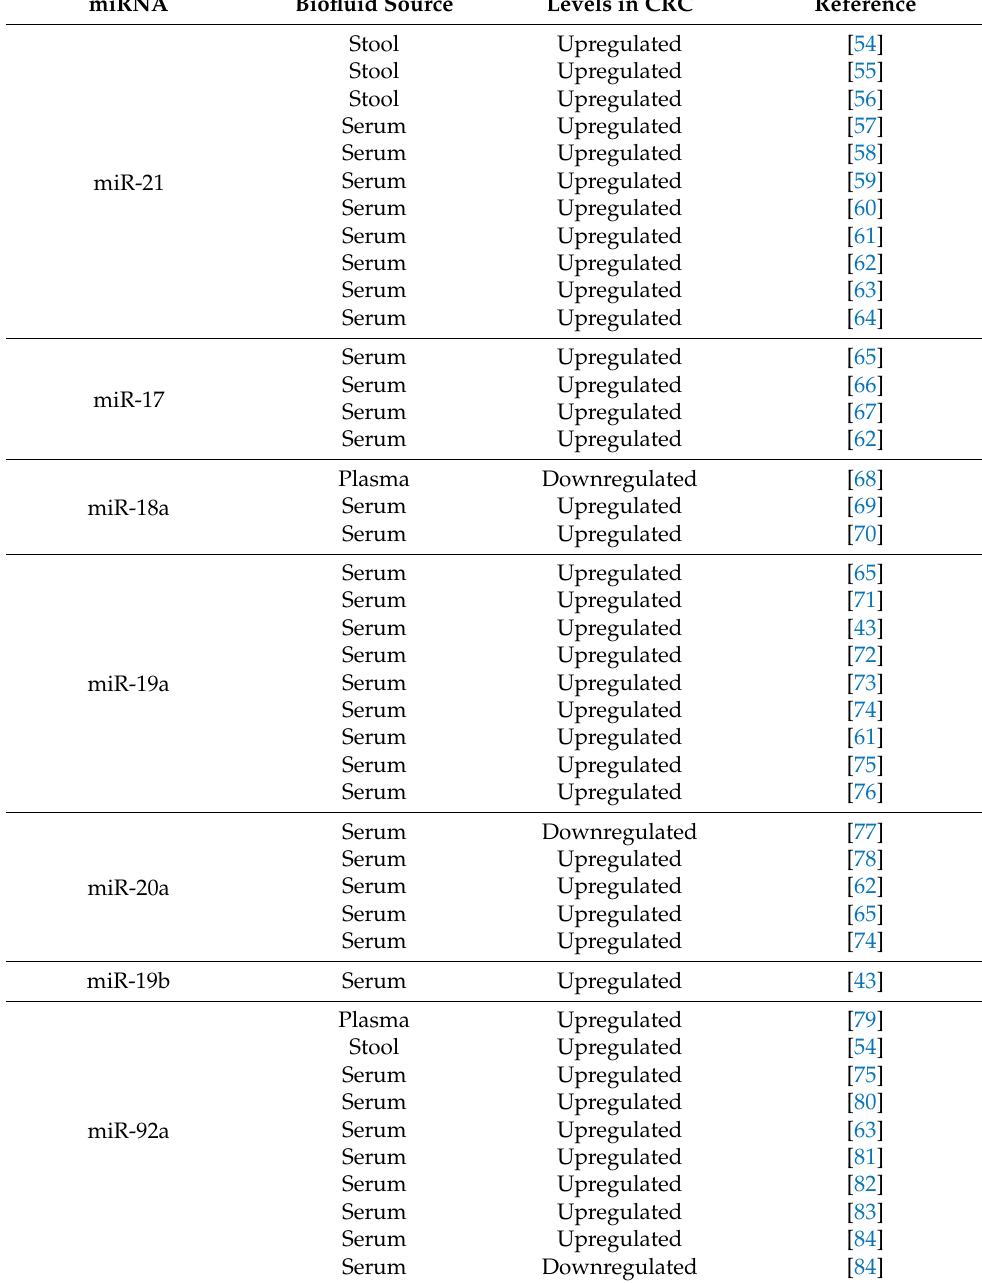
Table 1. Dysregulated miRNAs detected in noninvasive biofluids in CRC patient samples. miRNA Biofluid Source Levels in